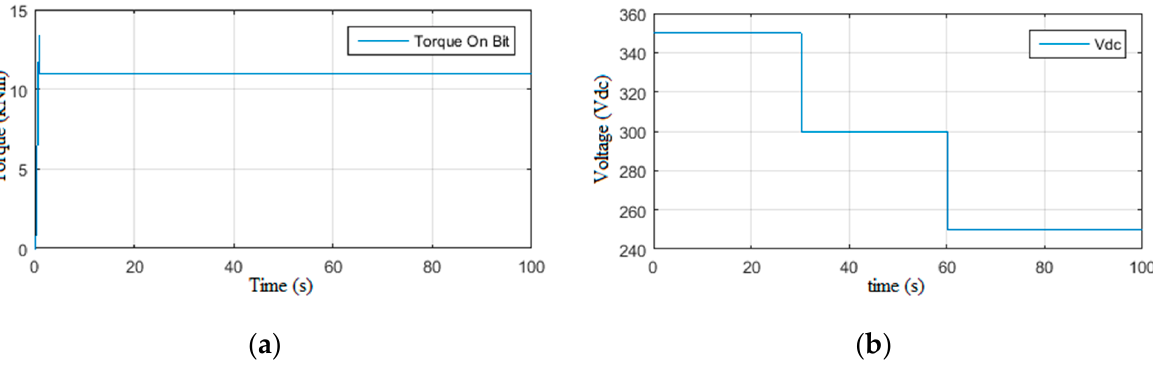
Figure 4. Open loop Responses of Top drive motor for Scenario 1.1: ( a ) Torque on bit, ( b ) Input voltage.